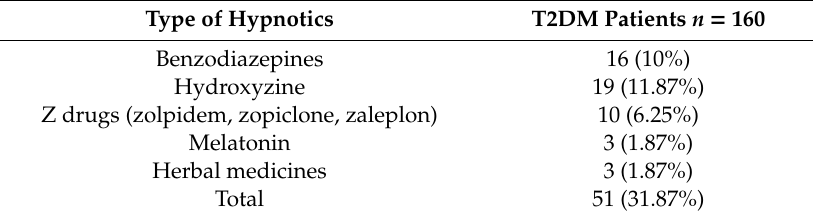
Table 3. Number and type of hypnotics taken by patients with T2DM.